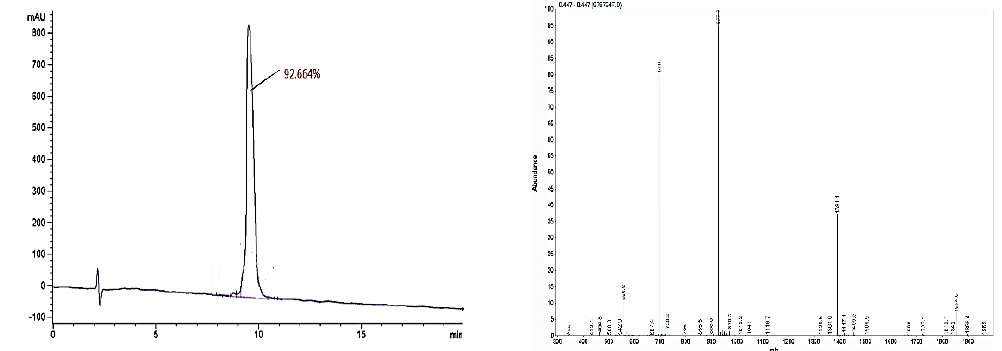
Figure 1. HPLC and MS analysis of synthetic epitope.